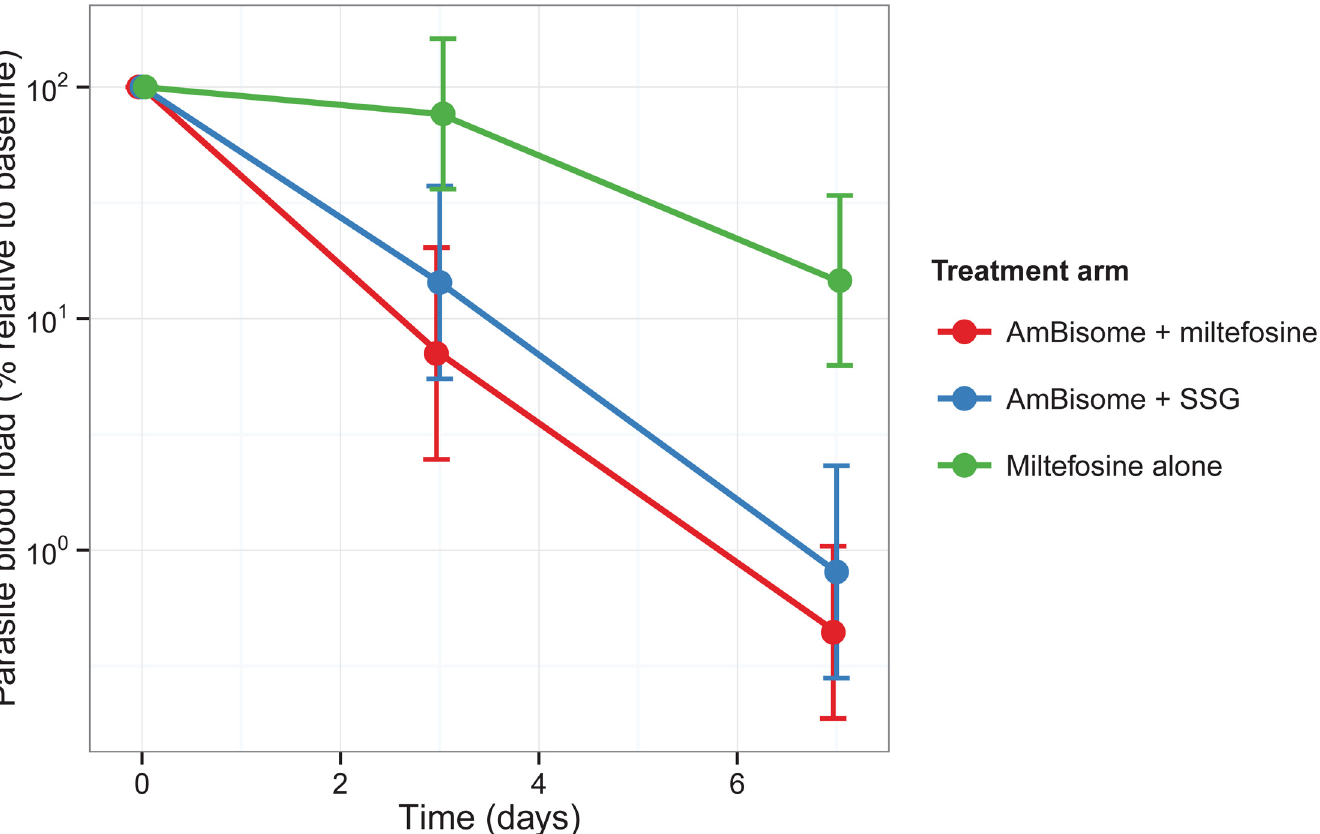
Fig 4. Parasite clearance from the blood in the first week of treatment. All parasite blood loads are relative to the individual parasite load at baseline. The full lines indicate the mean and the error bars its 95% confidence interval, stratified per treatment